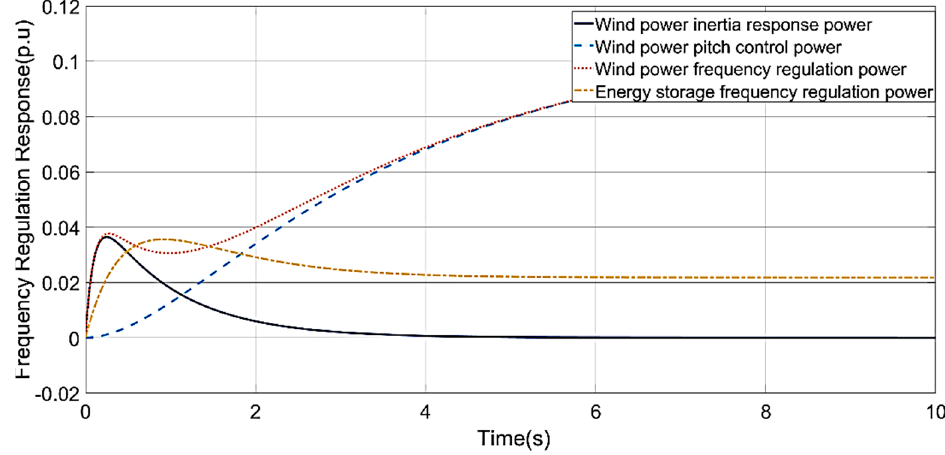
Figure 11. Step response comparisons of frequency regulation methods.